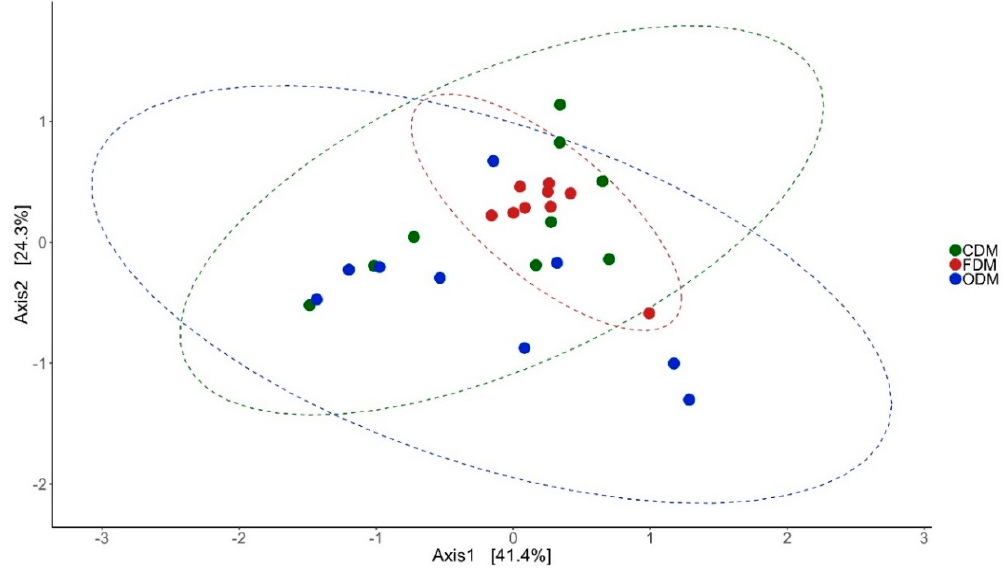
Figure 1. Differences in the beta diversity of the bacterial communities present in the distal intestine mucus of Atlantic salmon. The data in the ellipse-enclosed areas come from a multivariate normal distribution. The codes for the mucus samples are as follows: control group, CDM; florfenicol-fed group, FDM; oxolinic-acid-fed group, ODM.